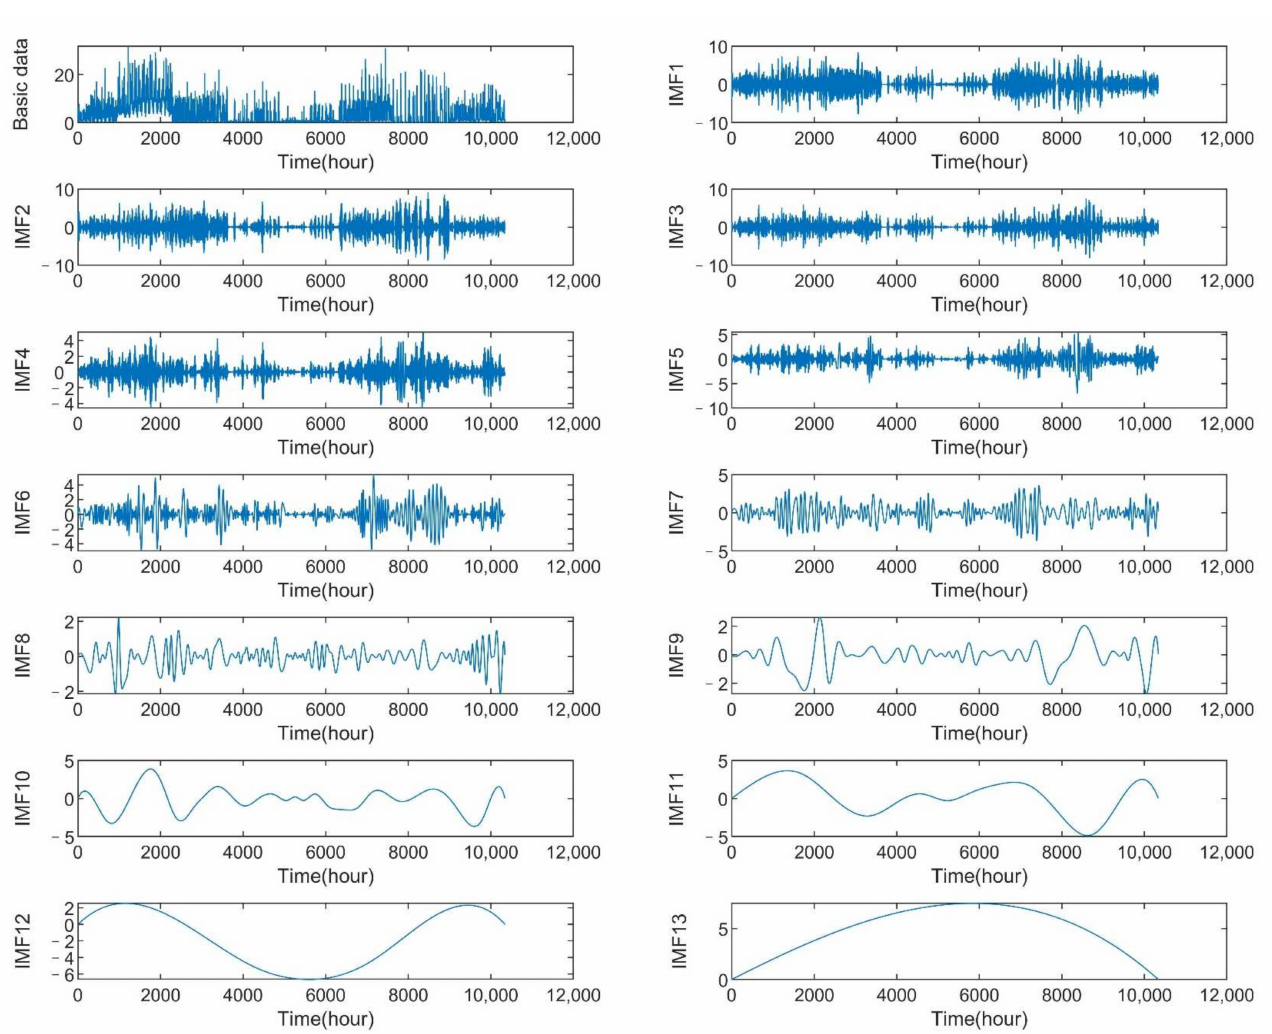
Figure 2. Empirical mode decomposition of reactive